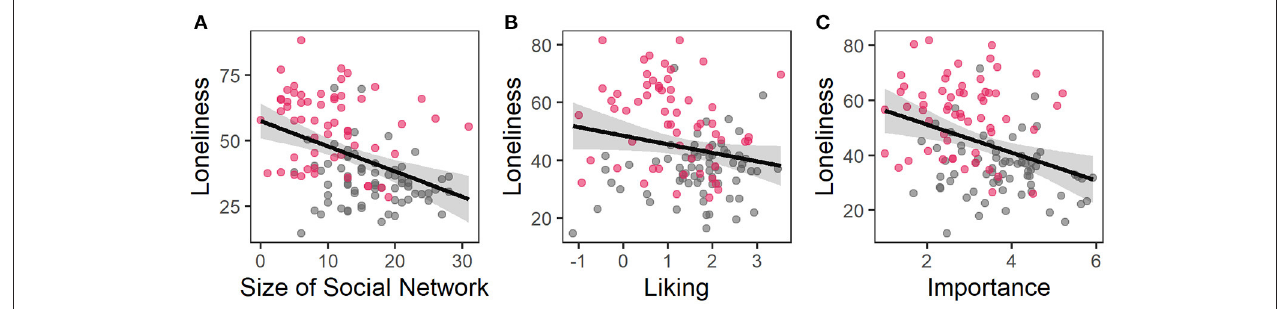
FIGURE 4 | Partial residual plots of regression model 2; the observed data is based on the values of (A) size of social network, (B) liking, and (C) importance of touch and the model error. The grey area represents the confidence interval, grey dots data of HC and red dots data of BPD.